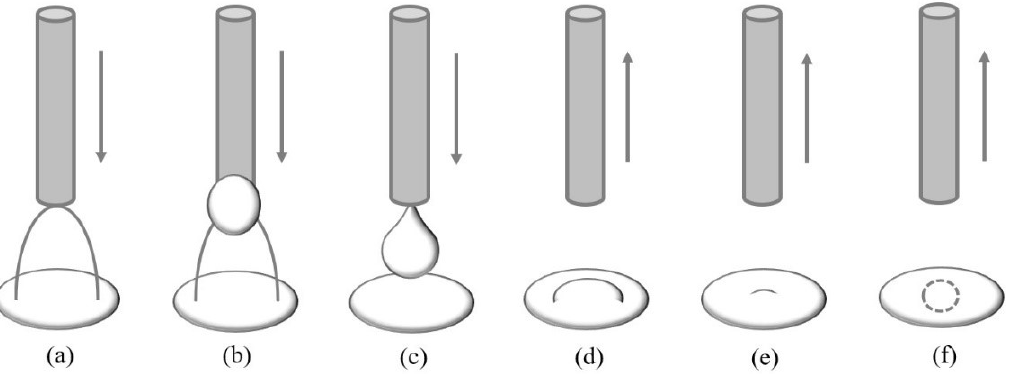
Figure 3. Simplified controlled cycle process of the molten pool ( a , b ) Arc pressure; ( c – e ) Droplet impact; ( f ) Residual energy transfer.